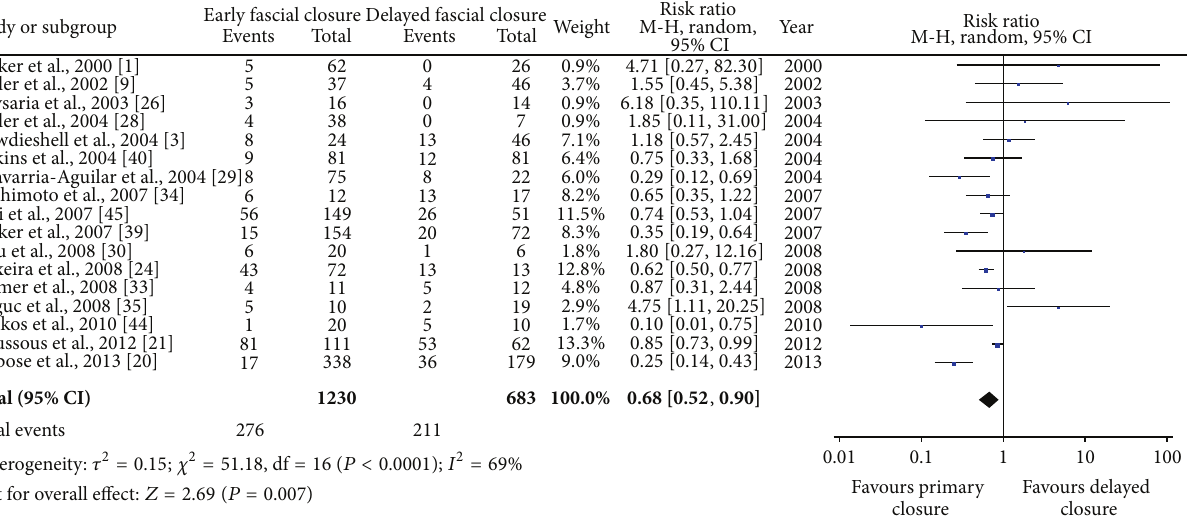
Figure 2: Comparison of postoperative complications after definitive closure between early fascial closure and delayed abdominal closure.